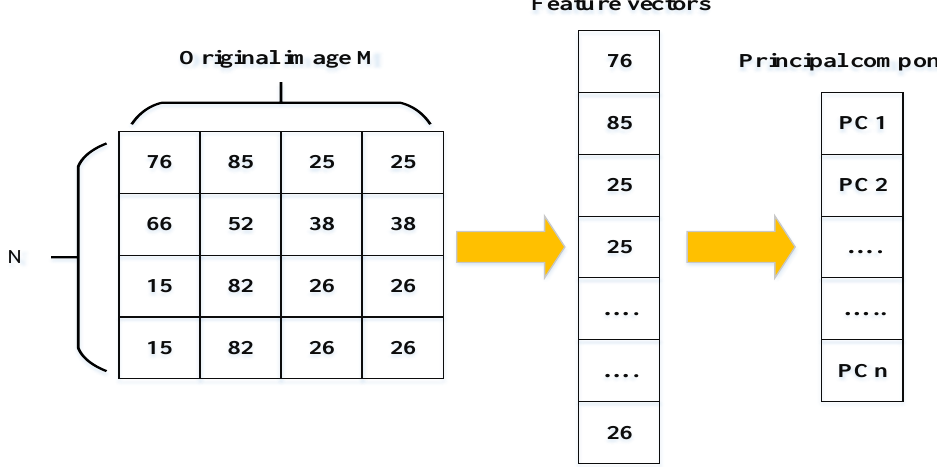
Figure 9. Example of dimensional reduction when applying principal component analysis (PCA) [62].